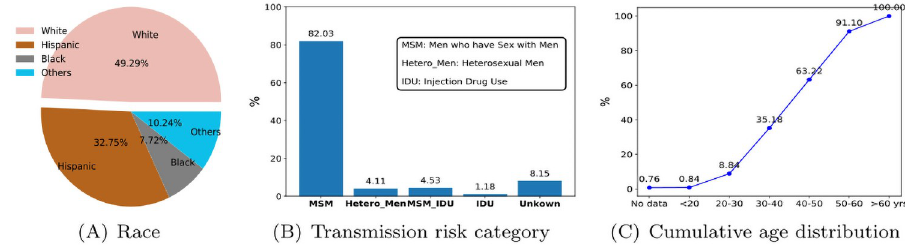
Fig 3. People living with HIV, San Diego PIRC. A. Racial distribution, B. Category of transmission risk, and C. Age distribution.